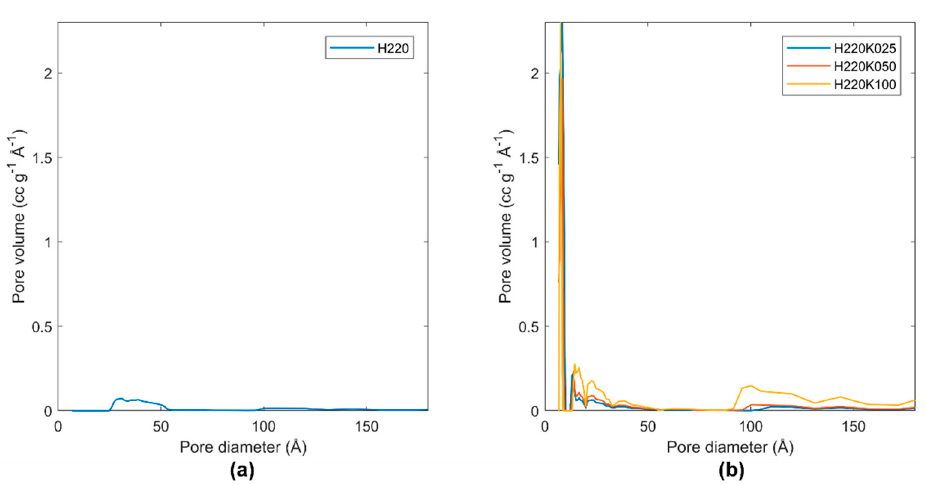
Figure 2. Pore size distribution (PSD): ( a ) hydrochar sample H220; and, ( b ) GSAC samples H220K025, H220K050, H220K100.